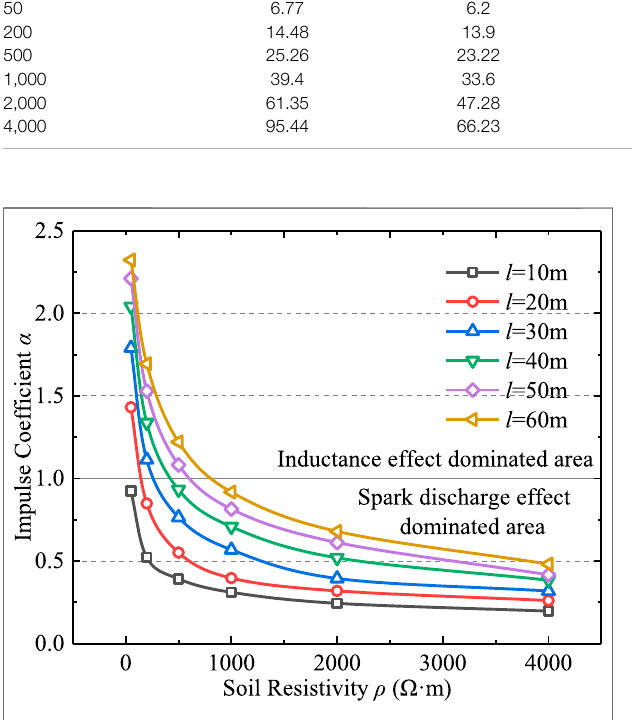
FIGURE 14 | Curve of impulse coef fi cient of graphite composite grounding